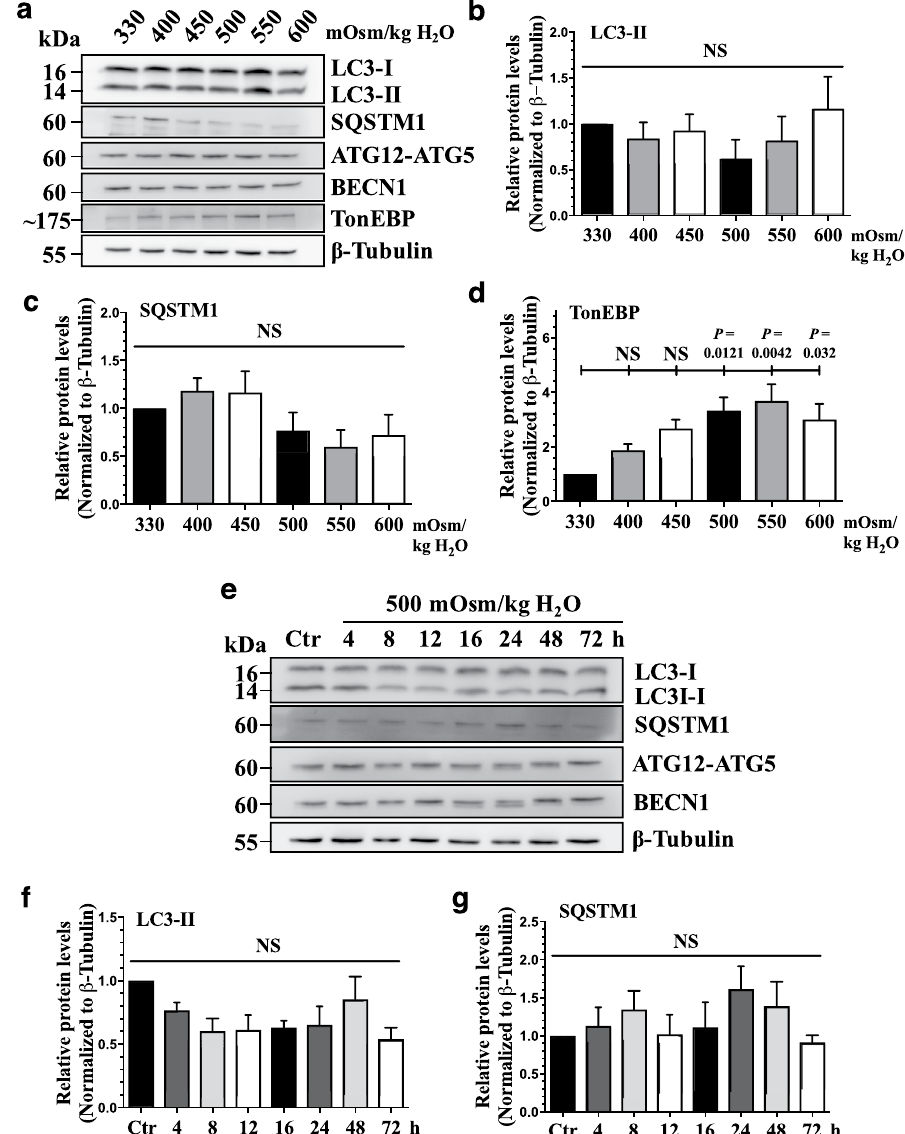
Figure 3. Hyperosmolarity does not upregulate the levels of canonical autophagic markers. ( a ) Western blot analysis of NP cells cultured under increasing osmolarity (330–600 mOsm/kg H 2 O) showed that the levels of LC3-II, SQSTM1, ATG12-ATG5, and BECN1 did not change by hyperosmolarity. However, TonEBP expression increased under hyperosmotic condition. ( b – d ) Densitometric analyses of multiple Western blots represented by ( a ) confirmed significant induction of TonEBP, while LC3-II and SQSTM1 levels remained unaltered (n = 5). ( e ) Western blot analysis of NP cells cultured under hyperosmotic condition for increasing lengths of time demonstrated that LC3-II, SQSTM1, ATG12-ATG5, and BECN1 levels were unaffected by hyperosmolarity up till 72 h. ( f – i ) Densitometric analyses of multiple Western blots shown in ( e ) (n = 3). Bars represent mean ± SEM. One-way ANOVA with Sidak’s multiple comparisons test was used to determine statistical significance. NS, non-significant. Western blot images were cropped and acquired under same experimental conditions. See Supplementary Fig. S1 for examples of uncropped